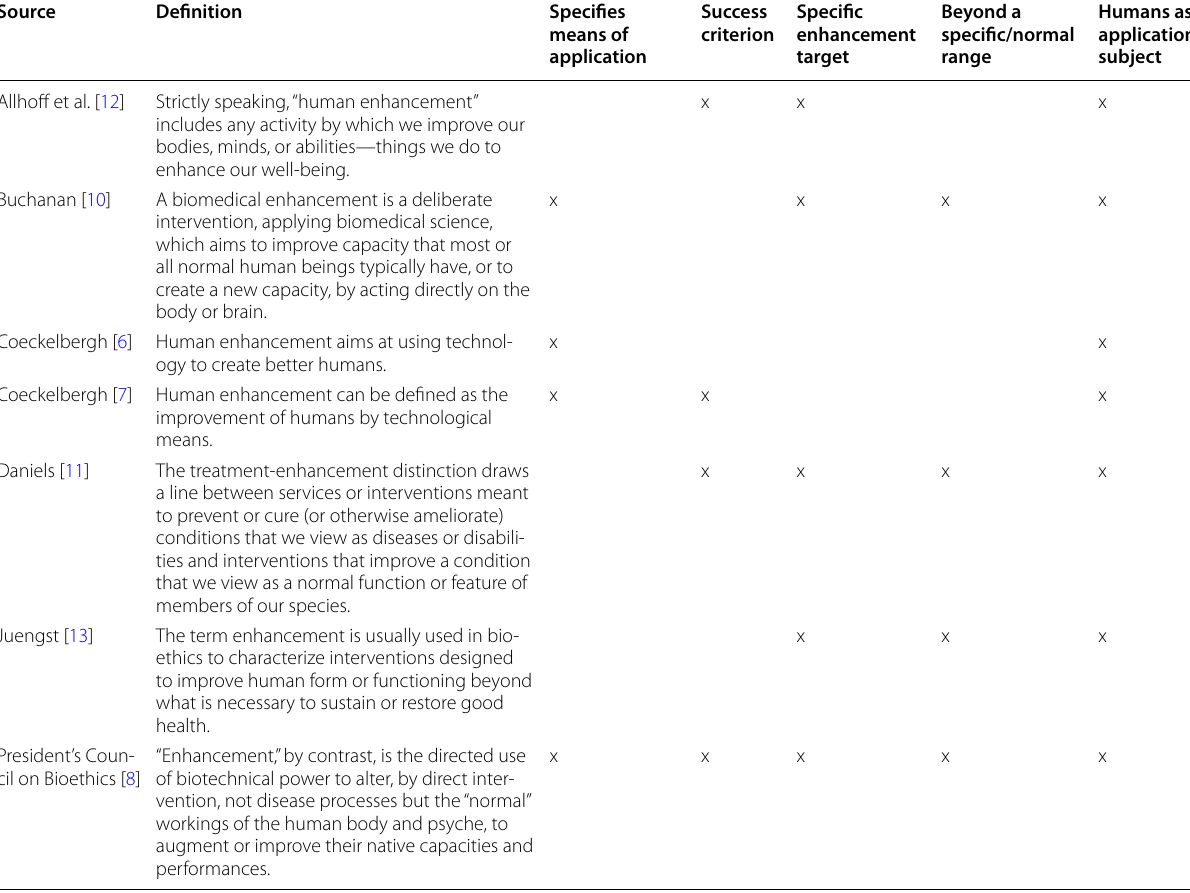
Note. Defintions are presented in alphabetical order of the